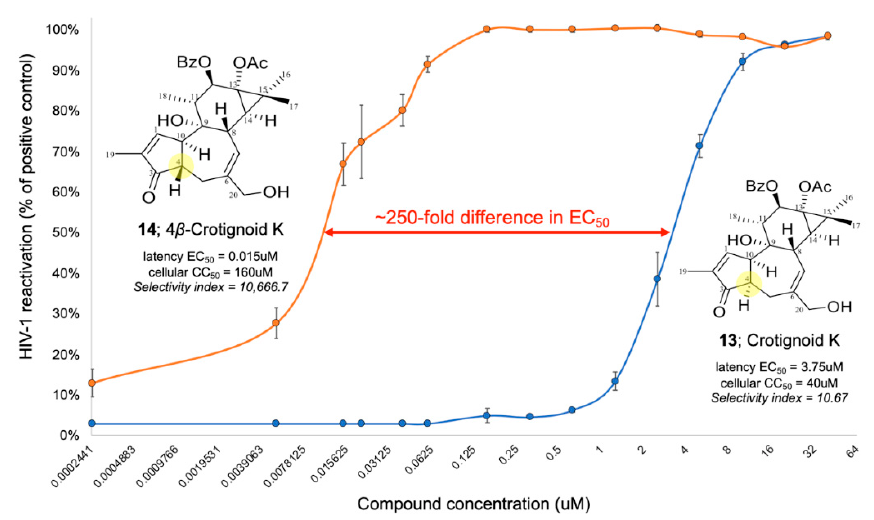
Figure 6. HIV-1 reactivation dose-response for stereoisomers crotignoid K ( 13 ) and 4 β -crotignoid K ( 14 ).